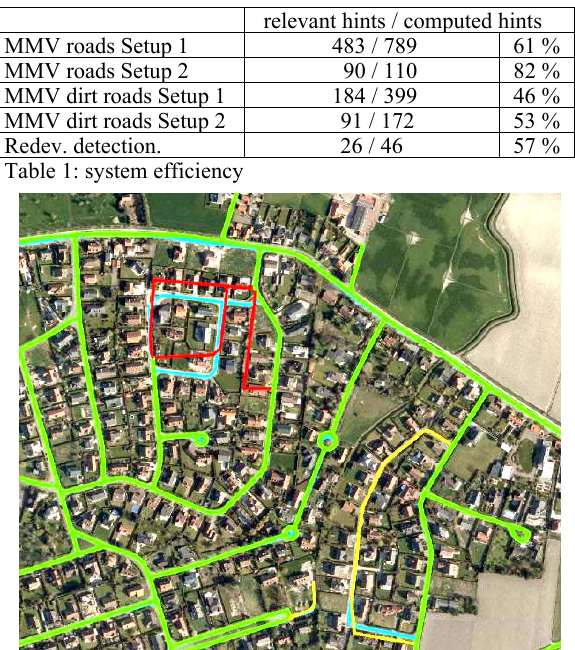
Figure 9: MMV successfully detects changed roads within a residential area (MMV outcome: correct = green, incorrect = red, undecided = yellow, reference = blue)